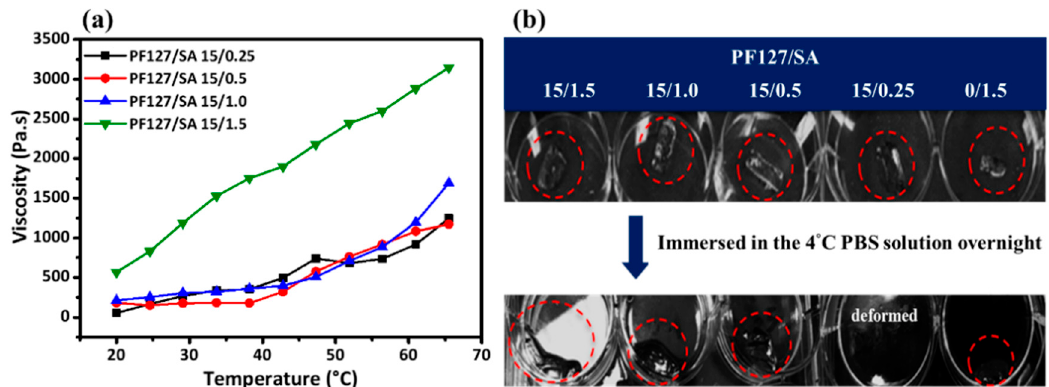
Figure 5. Effects of the IPN on mechanical and reversible properties determined using a rheometer: ( a ) at different temperatures under the same shear rate (0.1 s –1 ); ( b ) photographs of PF127/SA hydrogel reversible test at 4 °C (below lower critical solution temperature -LCST) (single crosslinked calcium alginate was used as a control group).